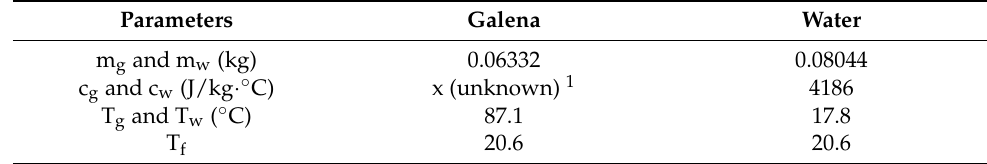
Table 1. Real data of the specific heat capacity experiment for the galena ore. Parameters Galena